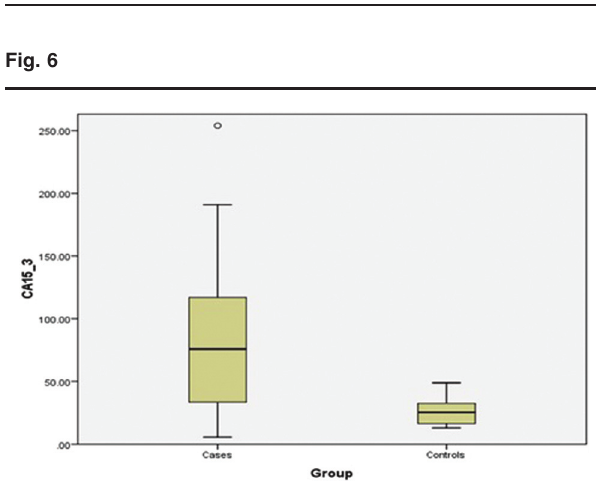
Comparison between cases and controls regarding carbohydrate